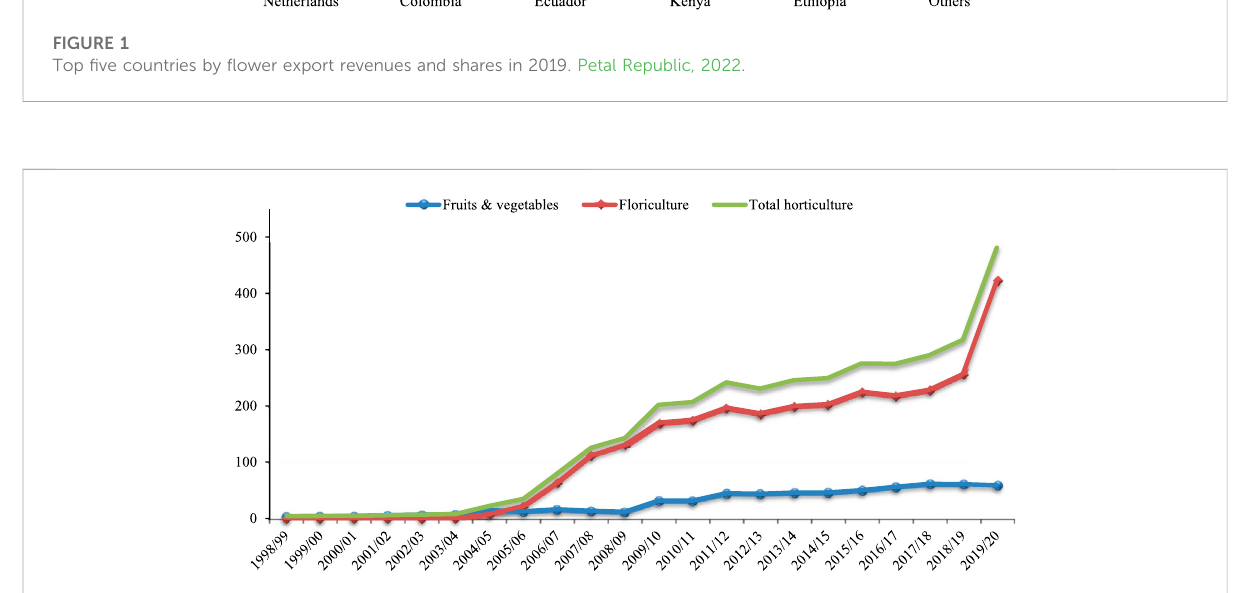
FIGURE 2 Export value of horticultural crops between 1998/99 to 2019/20 (in $ million). Oqubay, 2015; Oqubay, 2017; NBE,